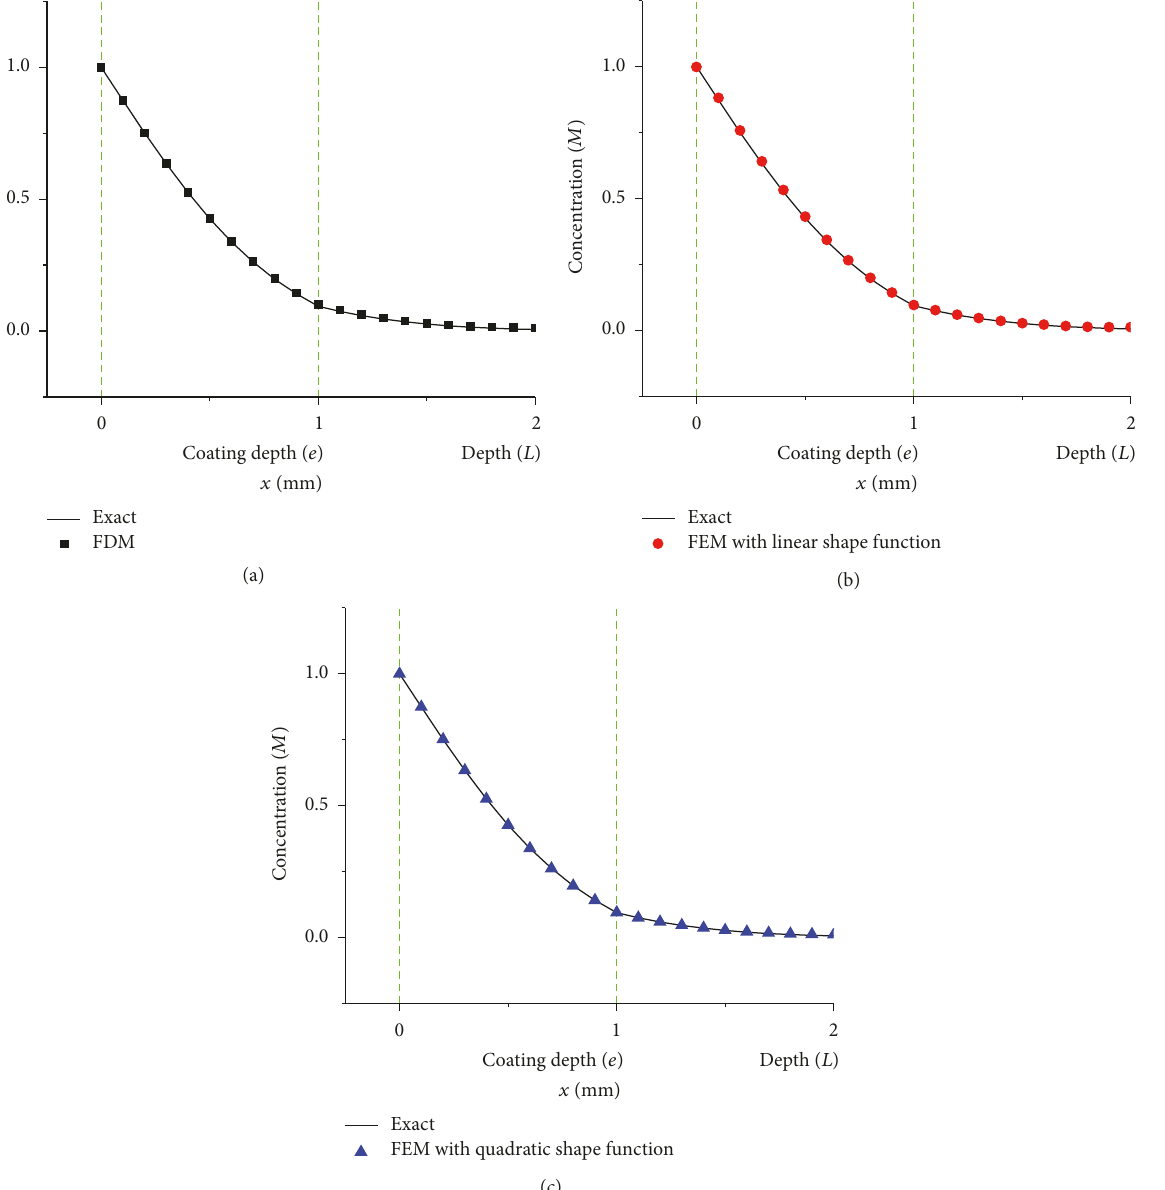
Figure 3: Comparison between an exact solution and numerical solutions by computing a coated material.